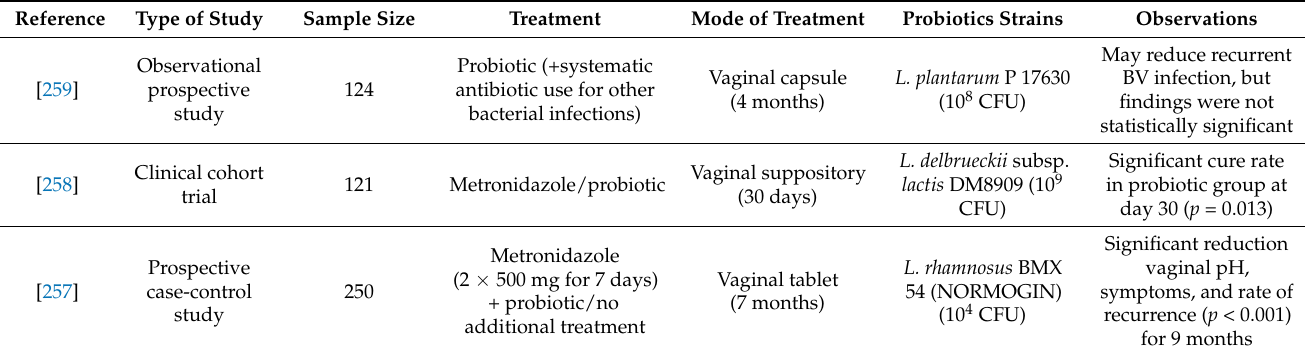
Table 5. Other types of studies (not randomized control trials) investigating the use of probiotics for